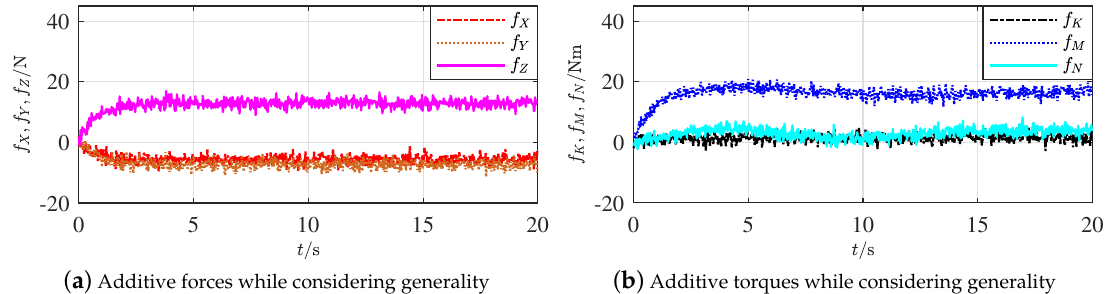
Figure 8. Additive forces and torques of rudder faults outside the hull while considering generality.